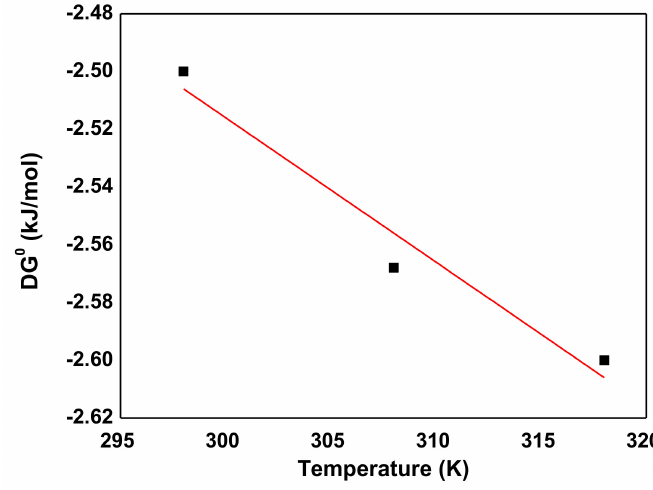
Figure 15. Free energy change versus temperature.